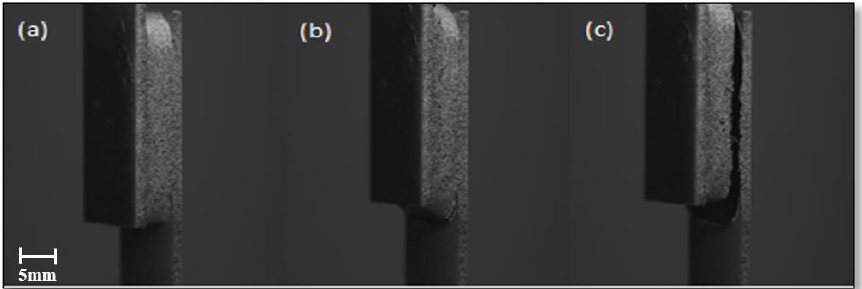
Figure 9. Image of 4 mm PDMS thickness: ( a ) before deformation; ( b ) beginning of rupture; ( c ) after rupture.